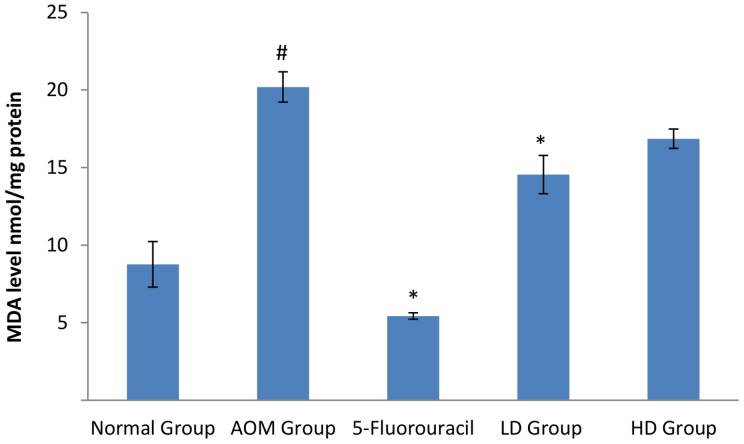
Effect of A. ilicifolius extract on lipid peroxidation level.All values are expressed as the mean ± SEM. Significant differences have values of P<0.05.